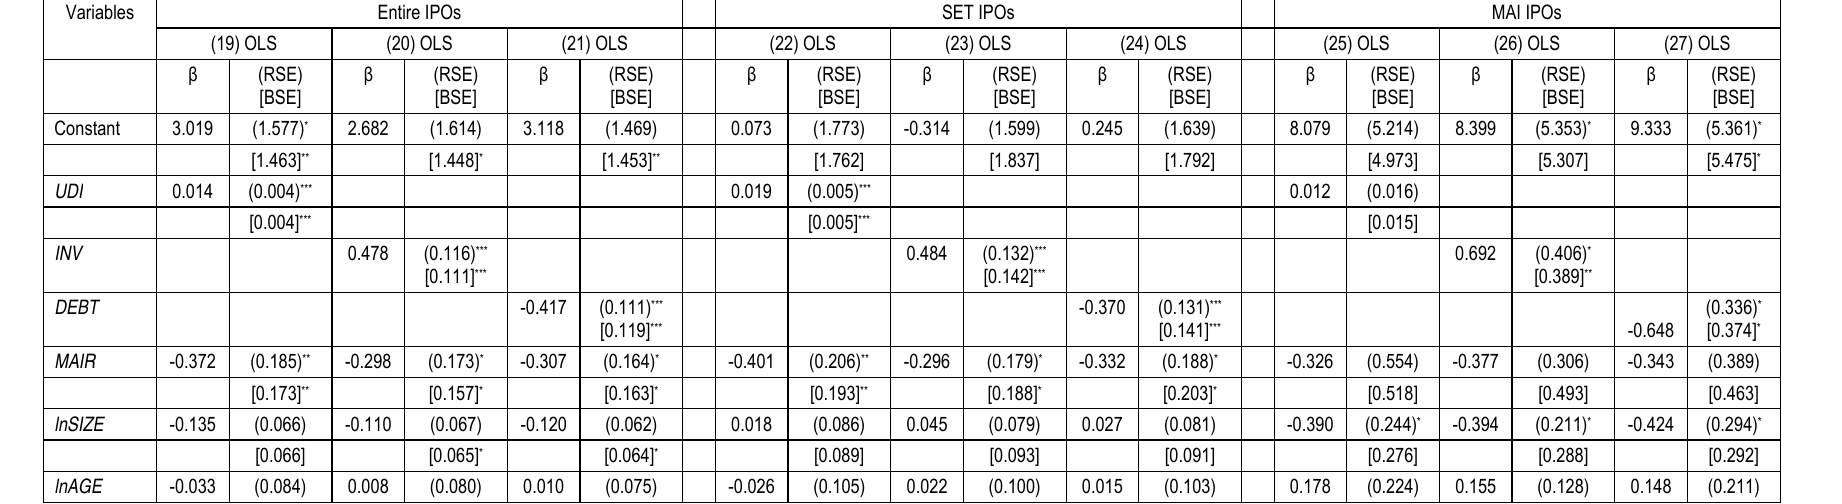
Table 8. OLS estimates-robust and bootstrap standard errors